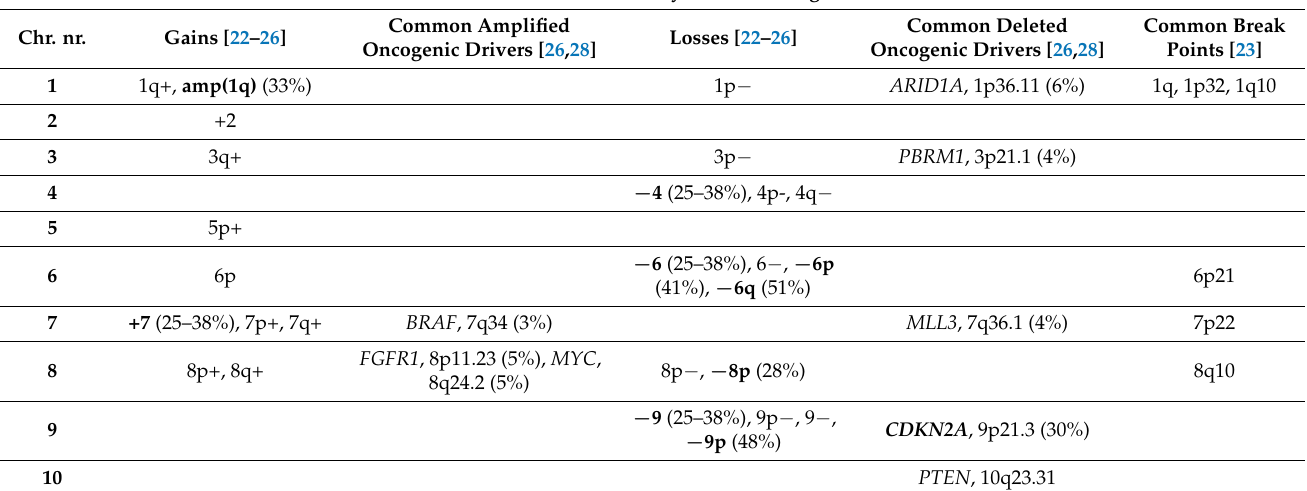
Table 1. Overview of cytogenetic alterations and commonly altered oncogenic driver genes in pancreatic cancer. Compiled from